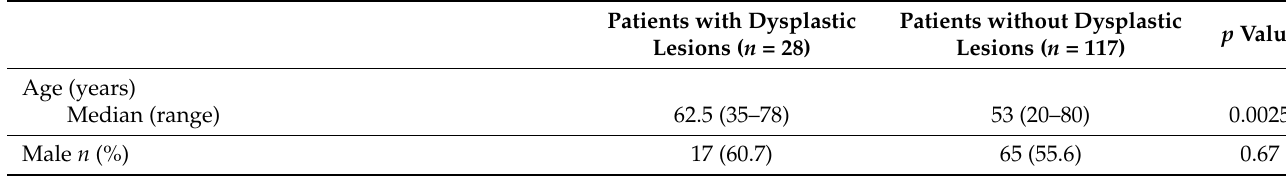
Table 3. Comparison between patients with dysplastic and non-dysplastic